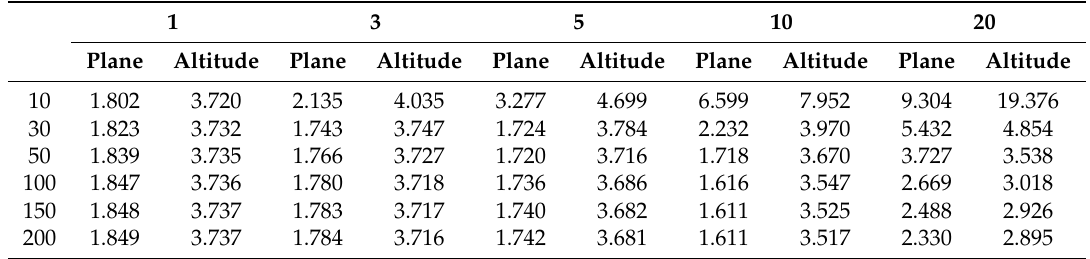
Table 7. Geometric accuracy with different offset parameters for GF2 and GF3 combined geopositioning. The first column relates to GF2 and the first row relates to GF3.